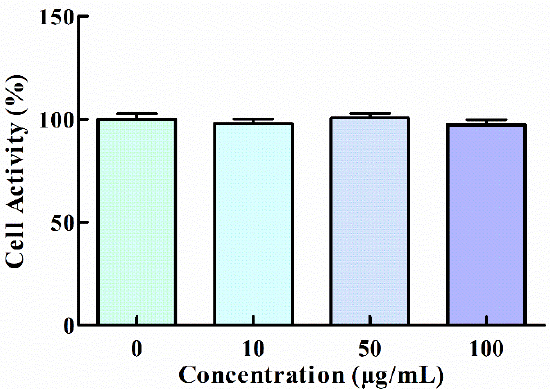
Figure 1. Effect of GNP on the viability of HT1080 cells. Data are shown as mean ± SD ( n =